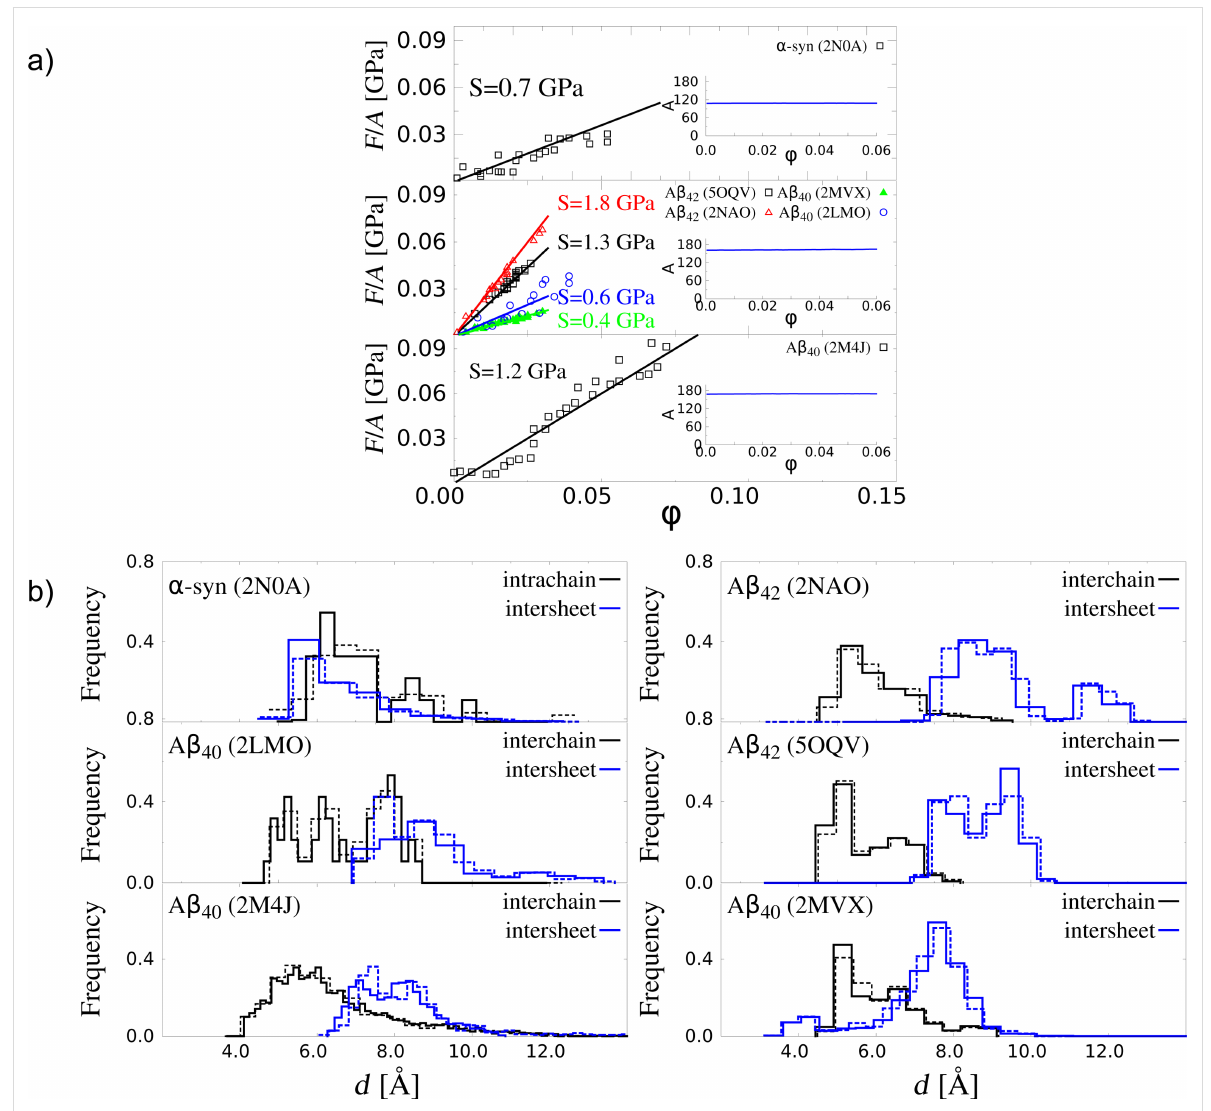
Figure 5: Results for shear deformation. (a) Stress–strain curves of α -syn and three A β 40 and two A β 42 fibrils. Circles refer to v = 0.0005 Å/ τ . The error bars are the same as the symbol size and they are based on 50 independent simulations for each structure. The inset shows the corresponding cross-section area in nm 2 . (b) Distributions of the HB lengths for (solid lines) and for a finite corresponding to the end of the linear regime (dashed lines), which is 0.04 for α -syn and 0.025 for A β amyloids. In the case of A β 40 with PDB ID: 2M4J has been calculated at strain